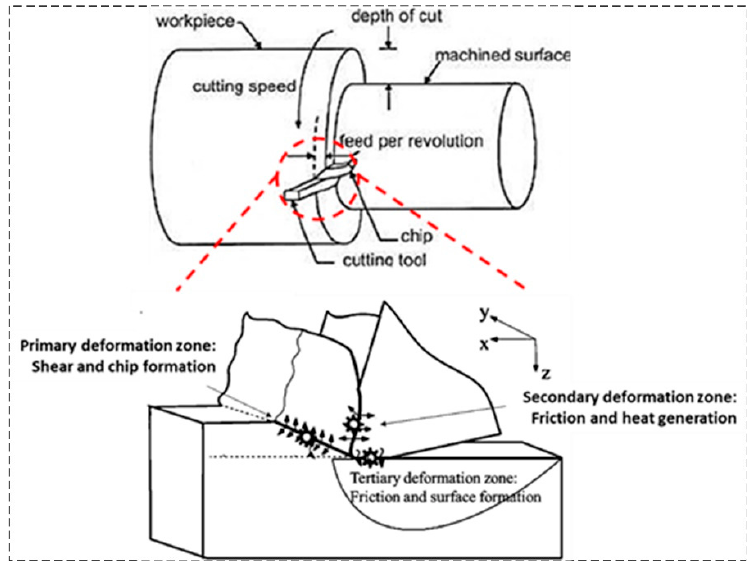
Figure 6. Shearing phenomenon and machining science during turning (redrawn from [32]).